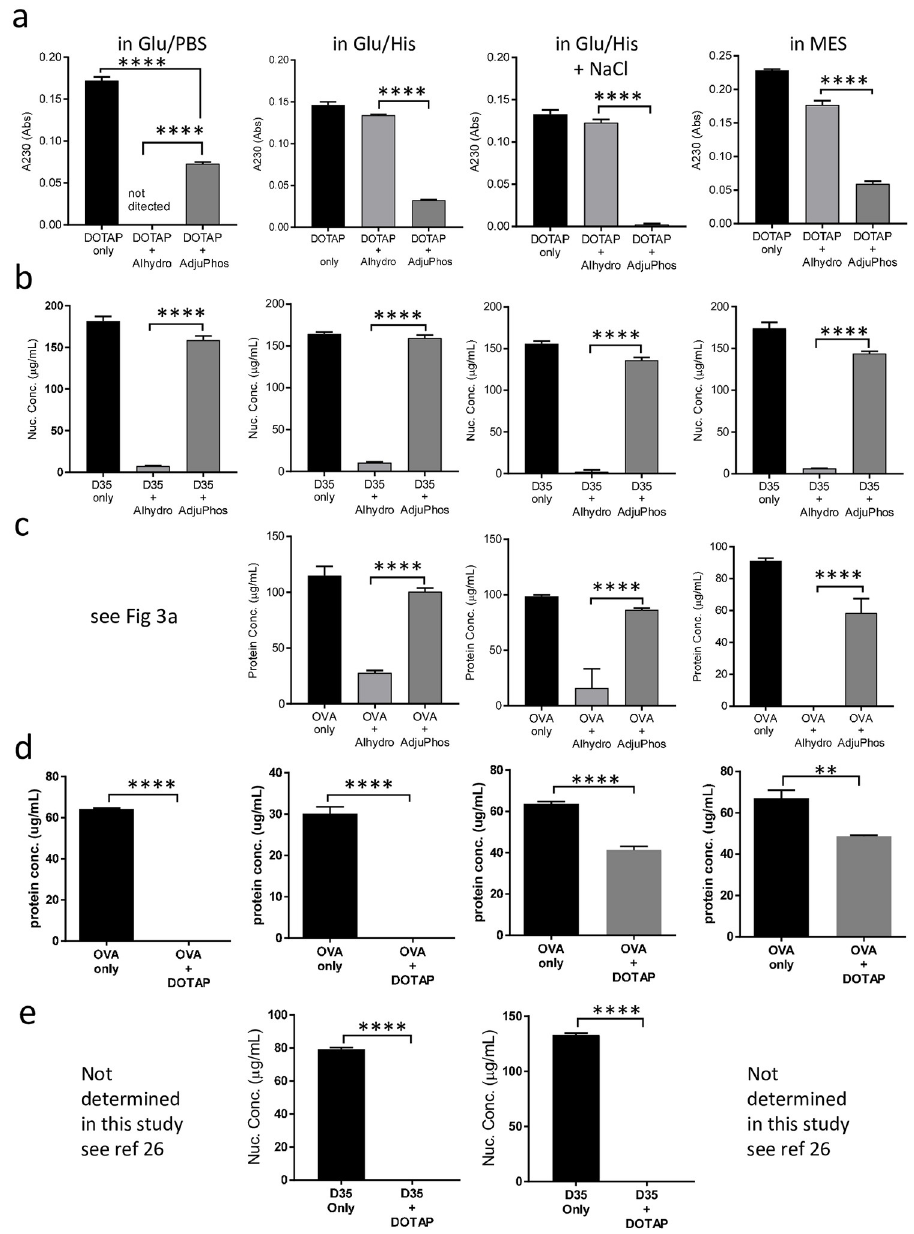
Fig 4. Interactions between adjuvant components in different buffers. The two-component interactions were examined using four different buffers. OVA (10 μ g), DOTAP (100 μ g), D35 (10 μ g), and Alhydrogel (40 μ g) were used. Two components were mixed in 100 μ L of the total volume and examined as described in the Methods section. (a) DOTAP vs. Alhydrogel/AdjuPhos interaction (b) D35 vs. Alhycrogel/AdjuPhos interaction (c) OVA vs. Alhycrogel/ AdjuPhos interaction (d) OVA vs. DOTAP interactions (e) D35 vs. DOTAP interaction. The bar graph indicates the mean ± SD of triplicates. Statistical significance is indicated by an asterisk in the bar graph; �� p < 0.01, ��� p < 0.001, ���� p < 0.0001 (parametric unpaired